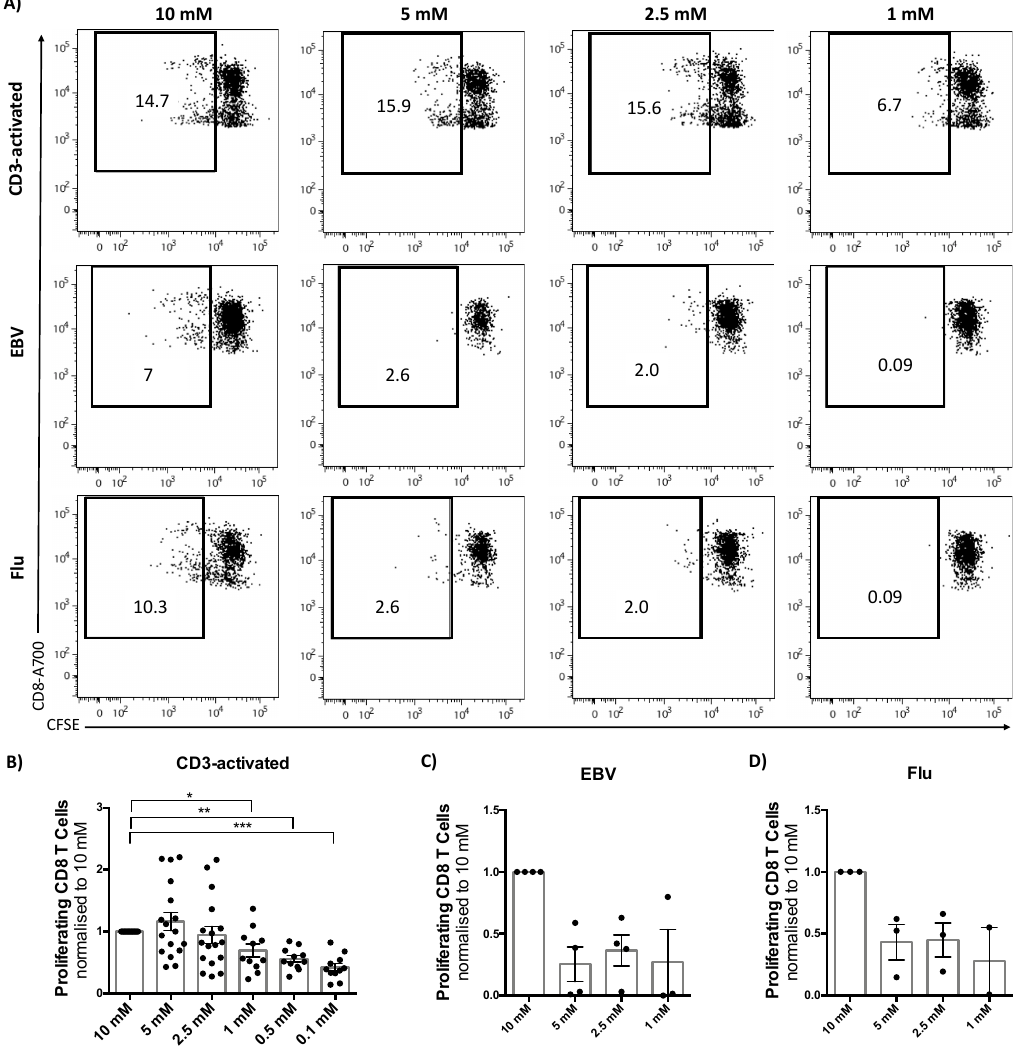
Figure 3. Glucose availability affects CD8 T cells proliferation. T cells were labelled with the fluorescent dye carboxyfluorescein succinimidyl ester (CFSE) to assess proliferation. Cells were stimulated for 72 h in different glucose concentrations as indicated and unstimulated cells were used as a control. ( A ) Dot plot showing CFSE dilution/T cell proliferation in different concentrations of glucose. ( B ) Fold change in proliferation of CD8 T cells normalized to proliferation in 10 mM glucose; CD3-activated, ( C ) EBV- and ( D ) flu-stimulated T cells in different concentrations of glucose. Mean ± SEM. Wilcoxon paired t test, * p < 0.05, ** p < 0.01, *** p < 0.001.